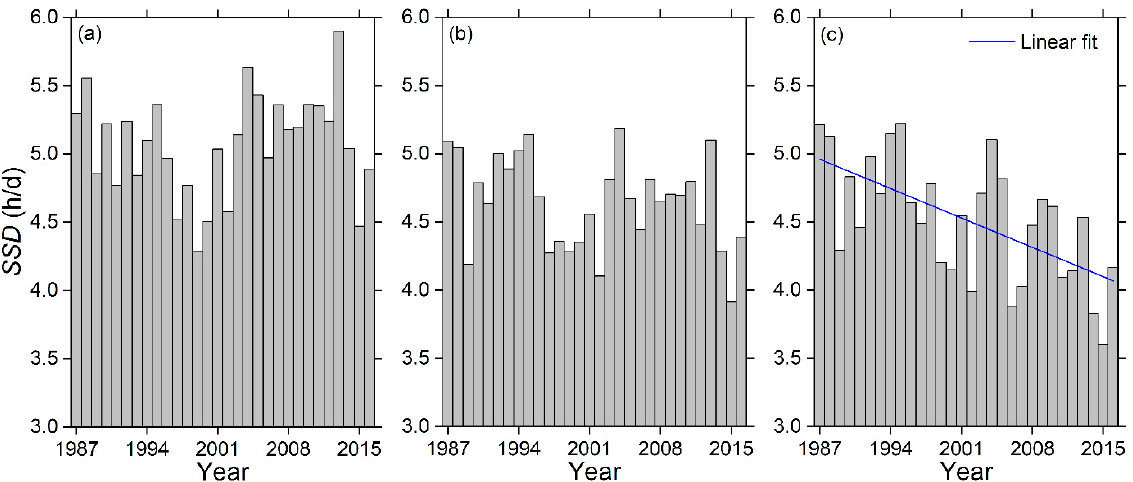
Figure 2. Interannual variation in annual mean sunshine duration ( SSD ) at ( a ) rural, ( b ) suburban, and ( c ) urban stations from 1987 to 2016.